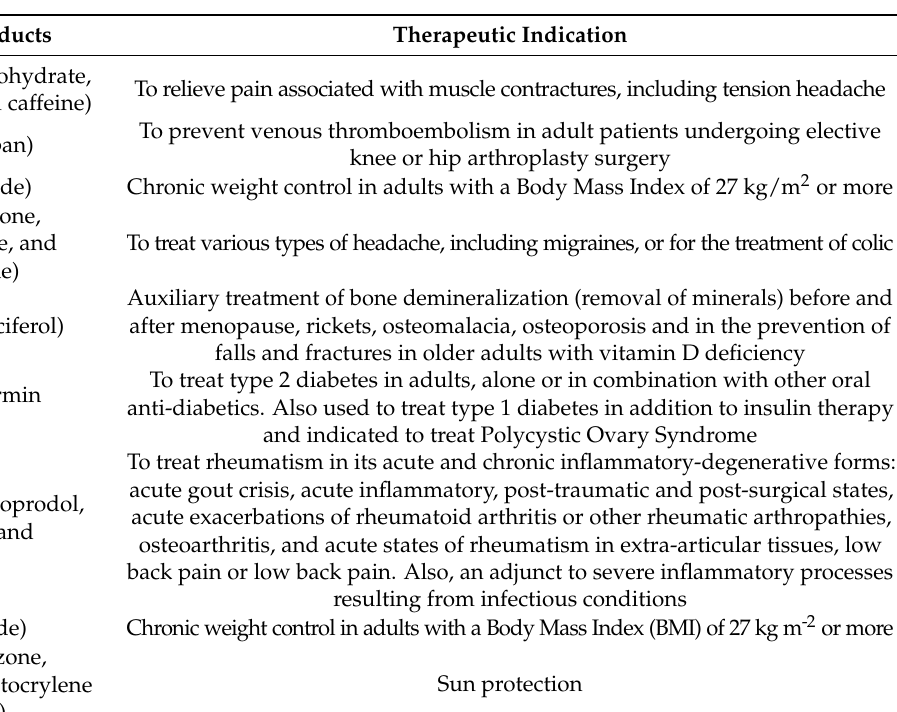
Table 1. Medicines and pharmaceutical products with the highest sales in Brazil, according to their active ingredient(s) and therapeutic